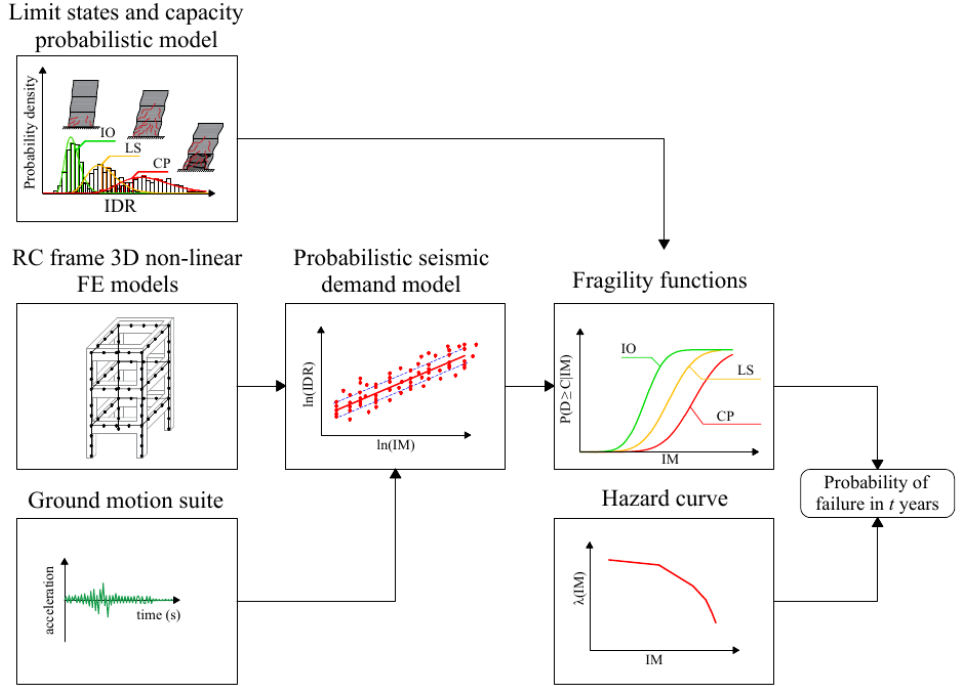
Figure 1. Summary of analytical seismic fragility and reliability analysis